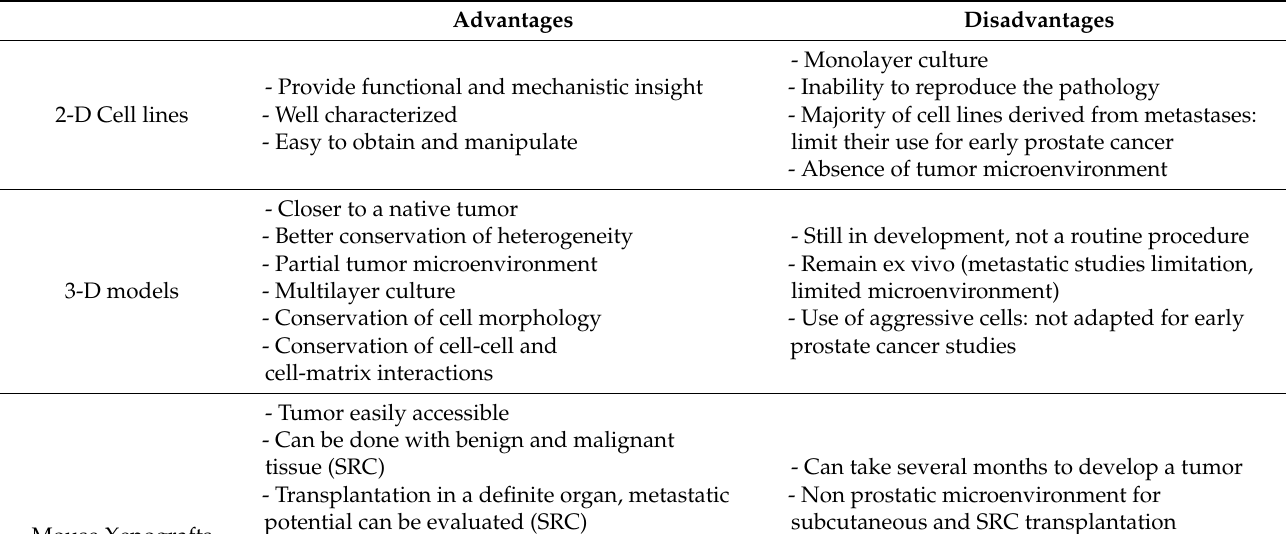
Table 2. Main advantages and disadvantages of the considered